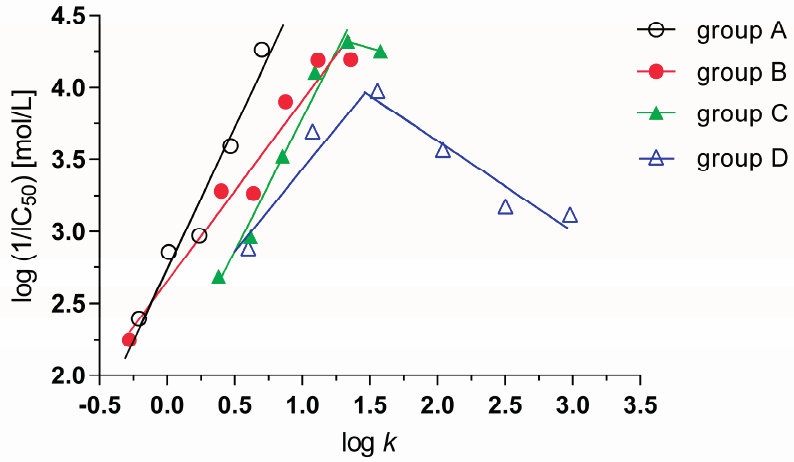
Figure 4. Dependence of PET-inhibiting activity on lipophilicity of studied compounds expressed as log